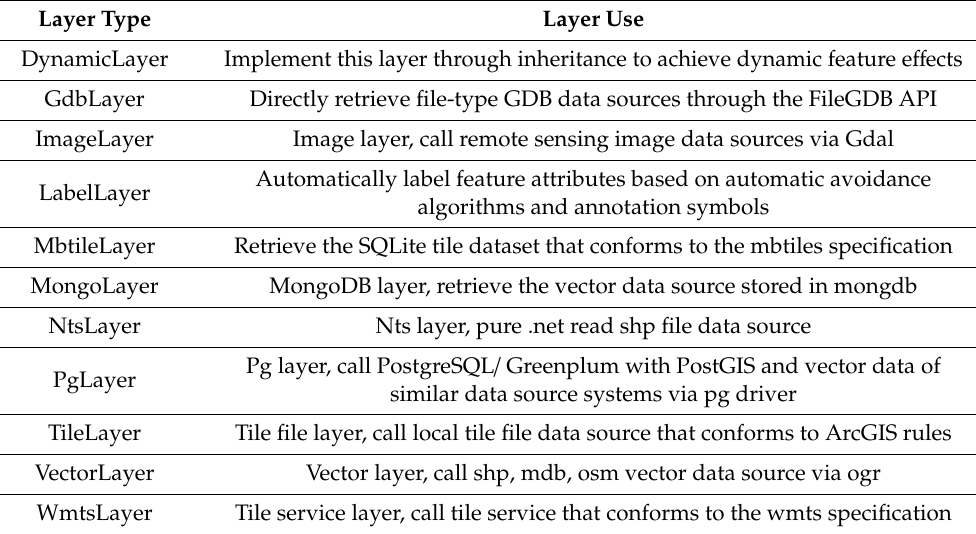
Table 3. Layer Table 3. Layer type.